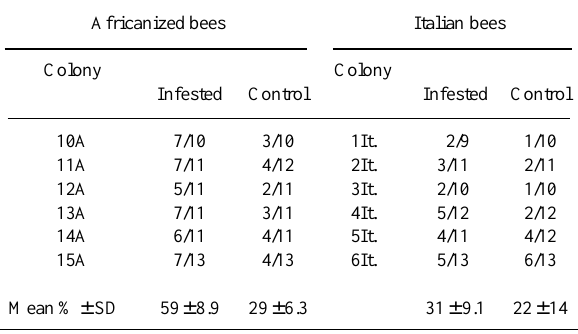
Table II - Proportion (number removed/number infested) of worker pupae artificially infested with Varroa jacobsoni , removed in